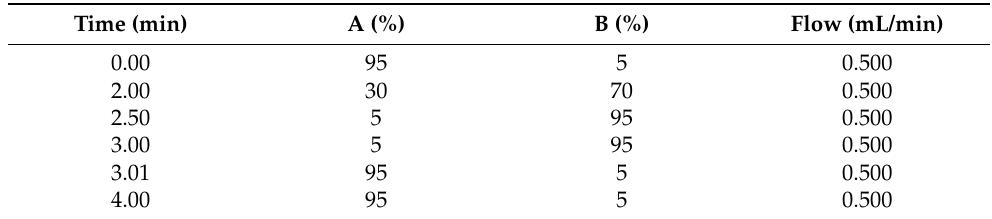
Table 1. Binary pump program used for fast constant flow elution with mobile phases A and B, as described in methods.